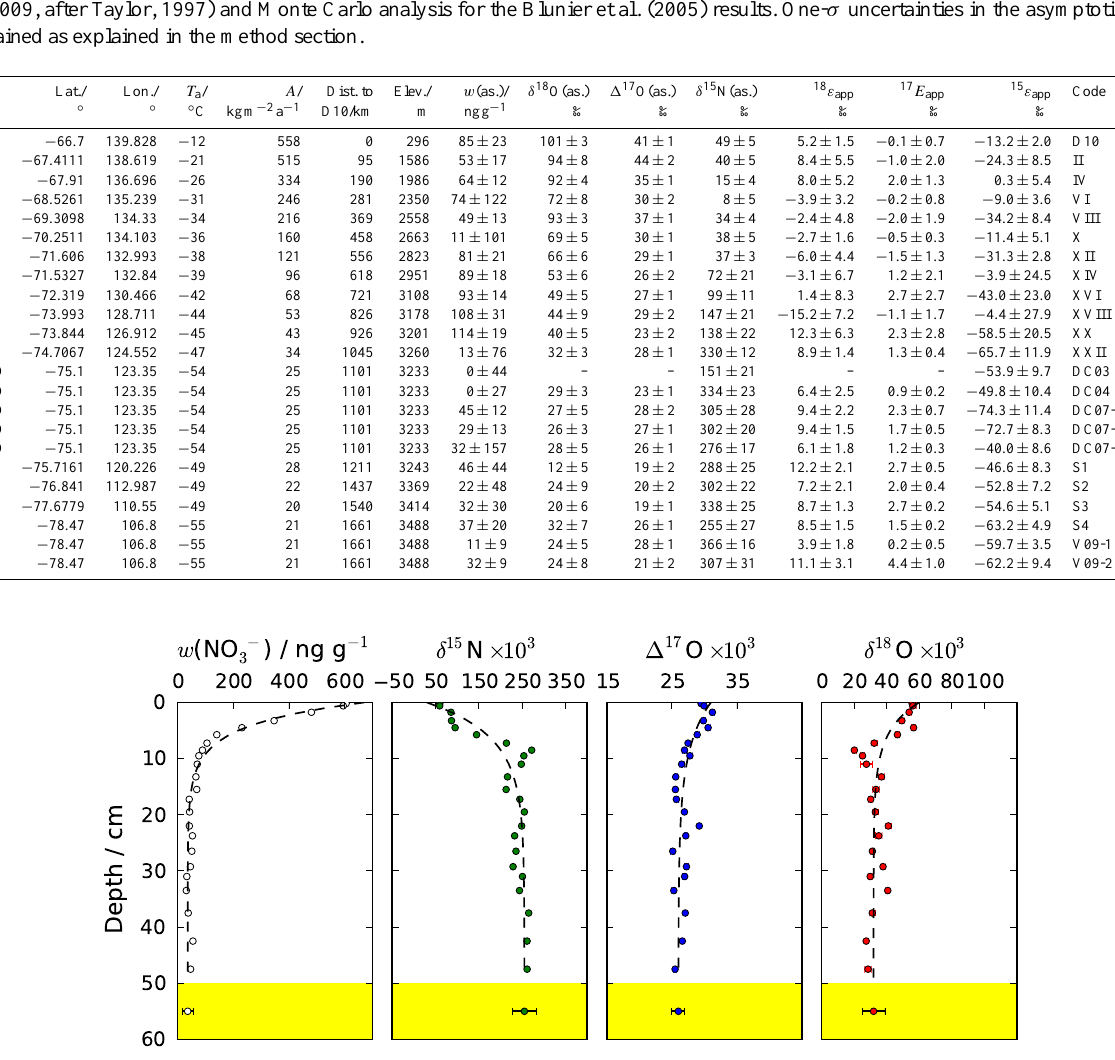
Fig. 3. Detailed view of nitrate mass fraction and isotopic composition profiles for snow pit S4 (panel 17 on Fig. 2a and b. The black dashed lines represent the fit to the data used to derive the asymptotic values as expressed in Eq.